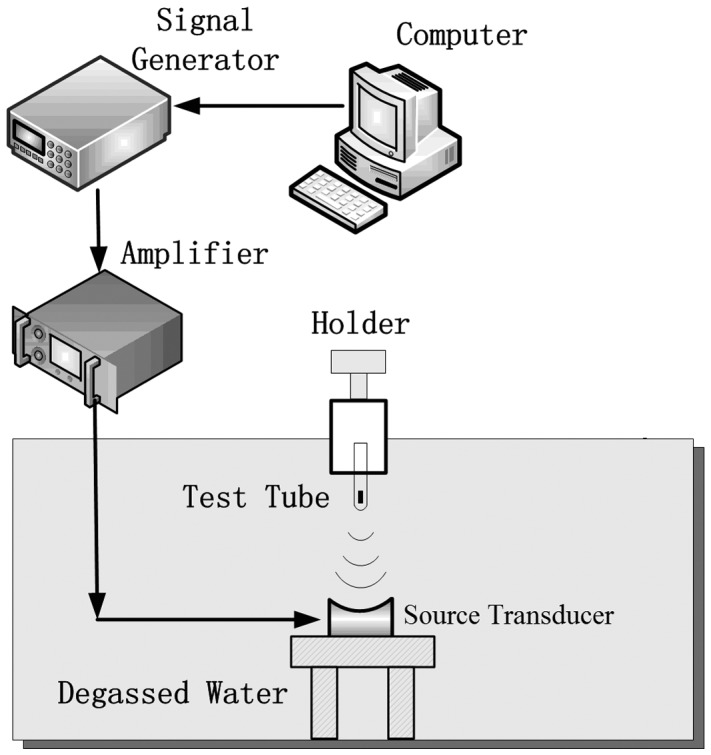
The schematic diagram of US-exposure system.